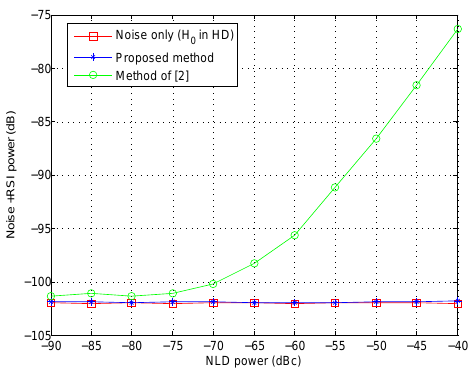
obtained after applying: 0